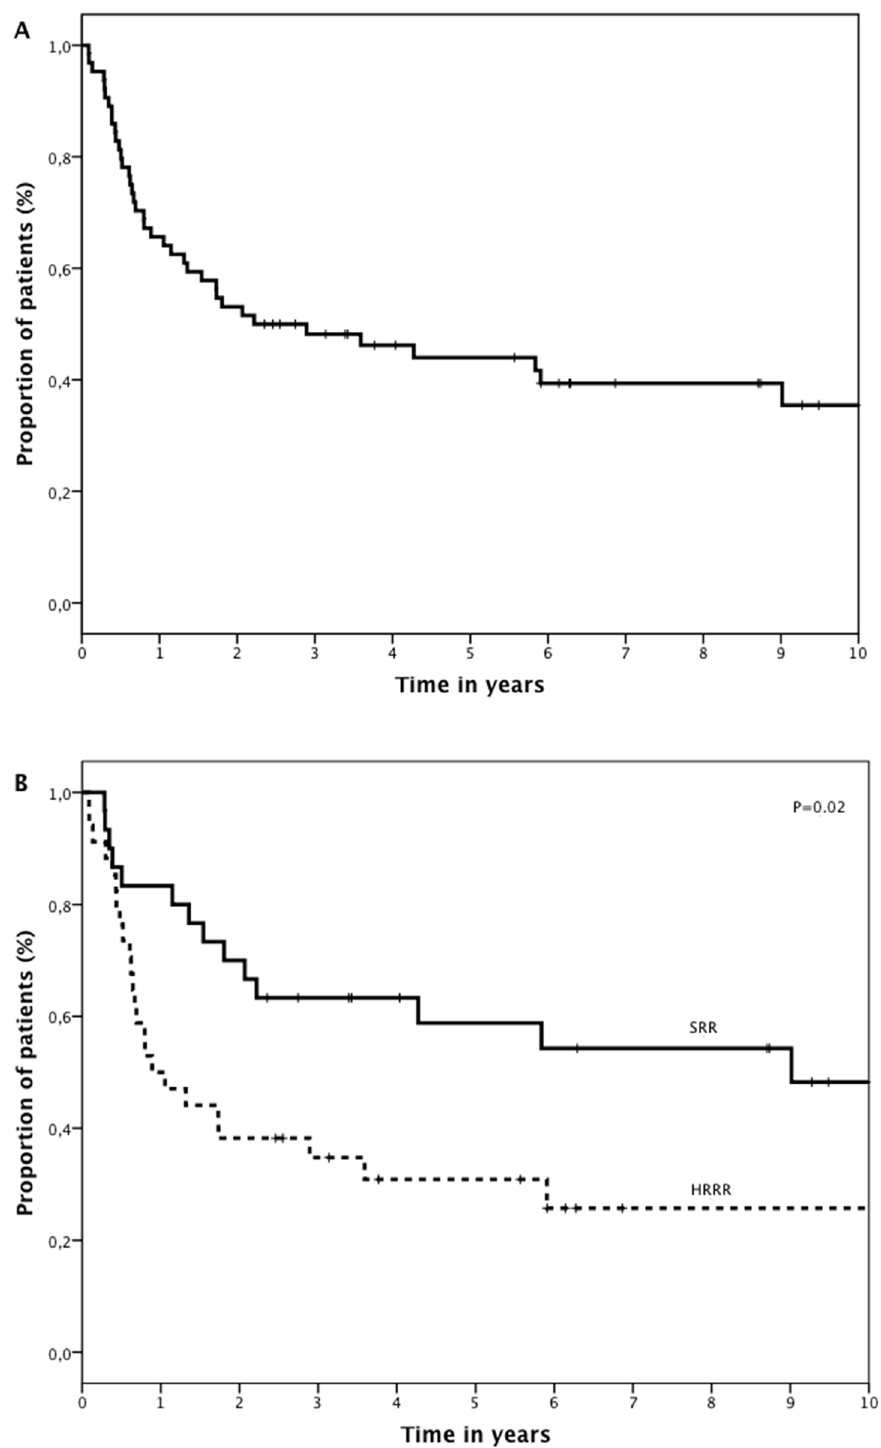
Fig 2. Survival of all relapsed and refractory ALL patients. (A) 5- years EFS for all patients: 44% (B) 5 years EFS for standard risk relapse (SRR): 59% versus high risk relapse or refractory (HRRR): 31%.